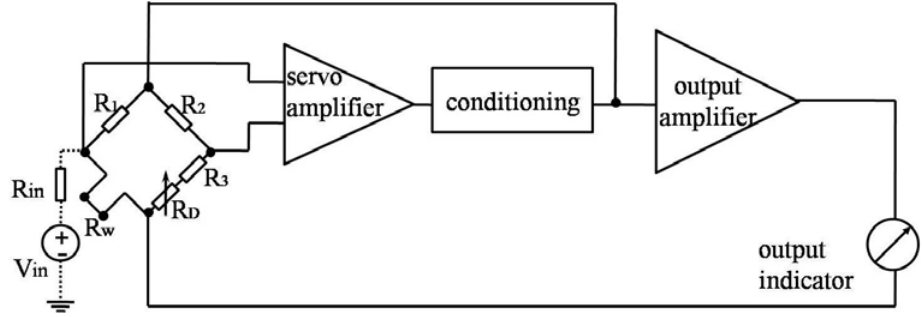
Figure 4. Schematic view of constant temperature circuit: R and V are only used for dynamic in